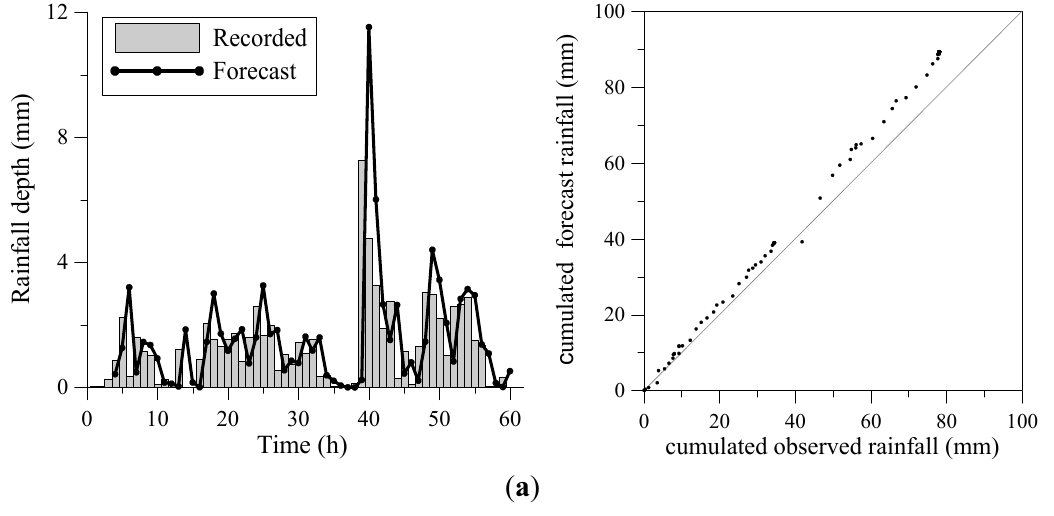
Figure 3. Results of evaluated criteria for grey forecast